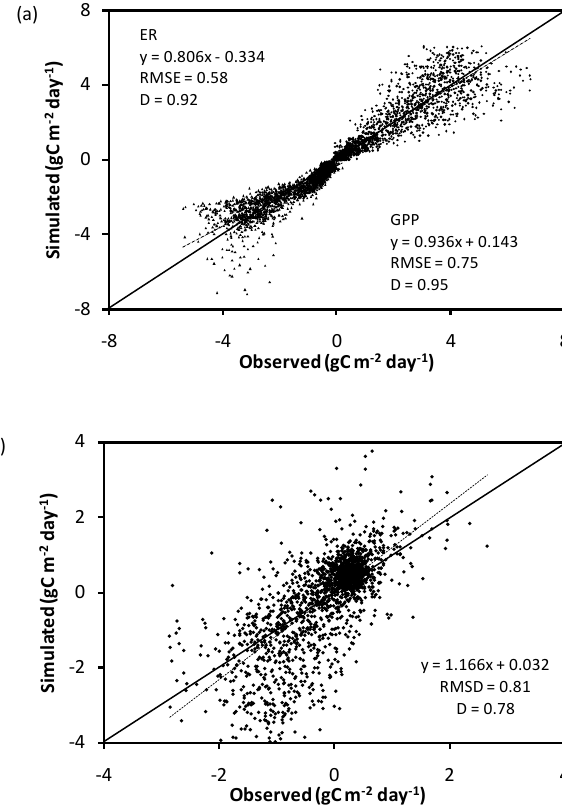
Fig. 7. The scatter plot of observed and simulated daily GPP and ER (a) and NEE (b) for 1999–2004, with the best fit relationship (dashed line) and the 1 : 1 line (solid black